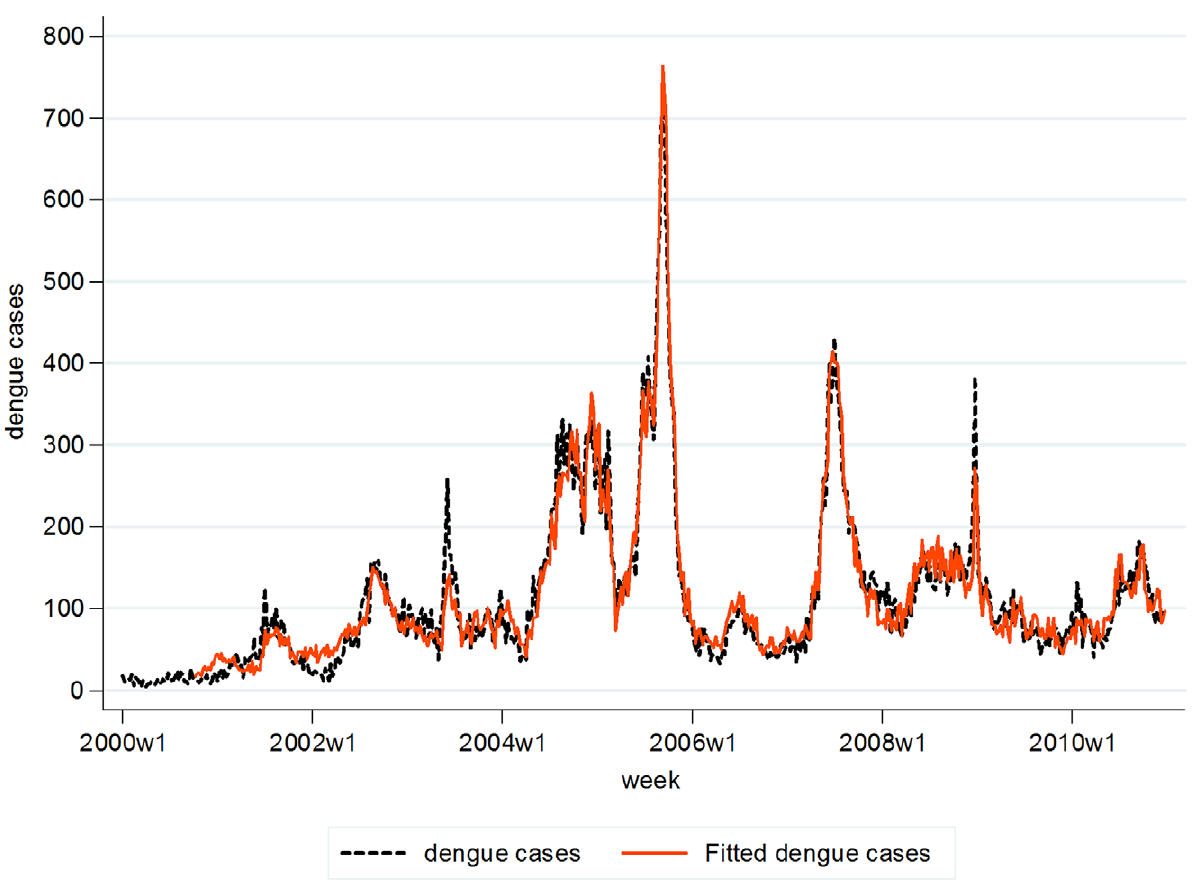
Figure 2. Fitted dengue cases versus reported dengue cases in 2000–2010. Model-based predicted or fitted dengue cases were plotted against actual reported dengue cases during the model training period. (Figure 4: Graph B). ROC curves as shown in Figure 4 suggest a sensitivity for diagnosing true outbreaks between 90% and 98% during years 2004–2010 corresponding with a 10% to 20% risk of false alarm; whereas, in 2011 the forecasting model showed 100% sensitivity with less than 3% risk of false positive. Overall, the ROC suggested that the selected model performed consistently at above 90% during both model development and forecast periods.